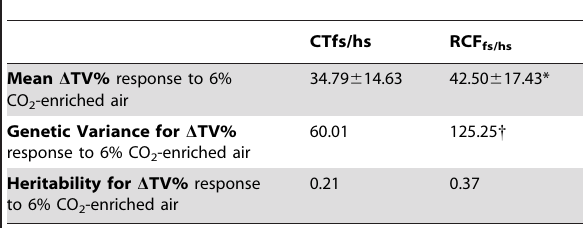
Fs=Full sibs; hs=Half-sibs. *Nested ANOVA: ‘postnatal treatment RCF vs. CT ’ : F 1,112 =8.29, p=0.0048; ‘sibship’: